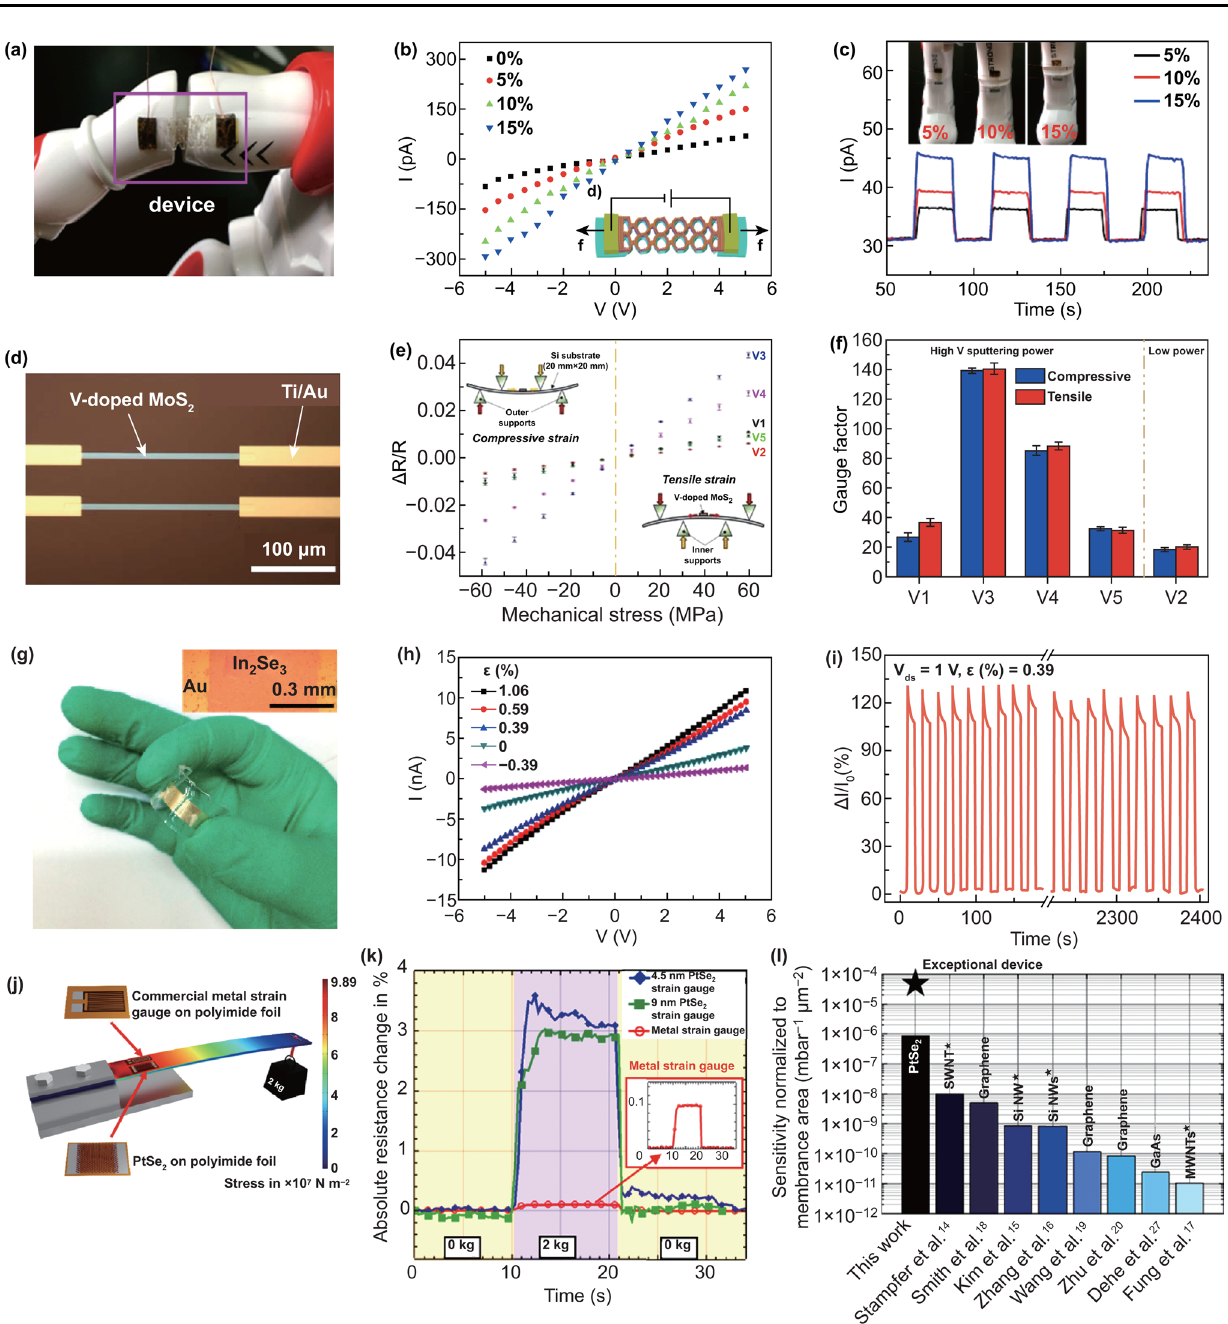
Fig. 15 Piezoresistive strain sensor based on 2D semiconductors. a Kirigami structure devices on the surface of elbow of a robot. b I–V curves of the devices under different deformation rates. c Strain sensor based on the Kirigami structure devices and the time-dependent response of devices. Reproduced with permission [199]. Copyright 2018, American Chemical Society. d Optical image of the V-doped MoS 2 strain sensor. e Change in resistance as function of strain. f Relationship between V-doping concentration and GFs of the sensor. Reproduced with permis- sion [198]. Copyright 2019, The Japan Society of Applied Physics. g Optical image of a 2D In 2 Se 3 strain sensor. h Device currents under both uniaxial tensile and compressive strain. i Multicycle normalized current change in the sensor under uniaxial tensile strain. Reproduced with permission [200]. Copyright 2016, American Chemical Society. j Bending beam setup with applied 2D PtSe 2 . k Electrical readout signal during the measurement with an absolute resistance change against time showing two PtSe 2 devices. l Comparison of the sensitivity with other pressure sensors. Reproduced with permission [201]. Copyright 2018, American Chemical